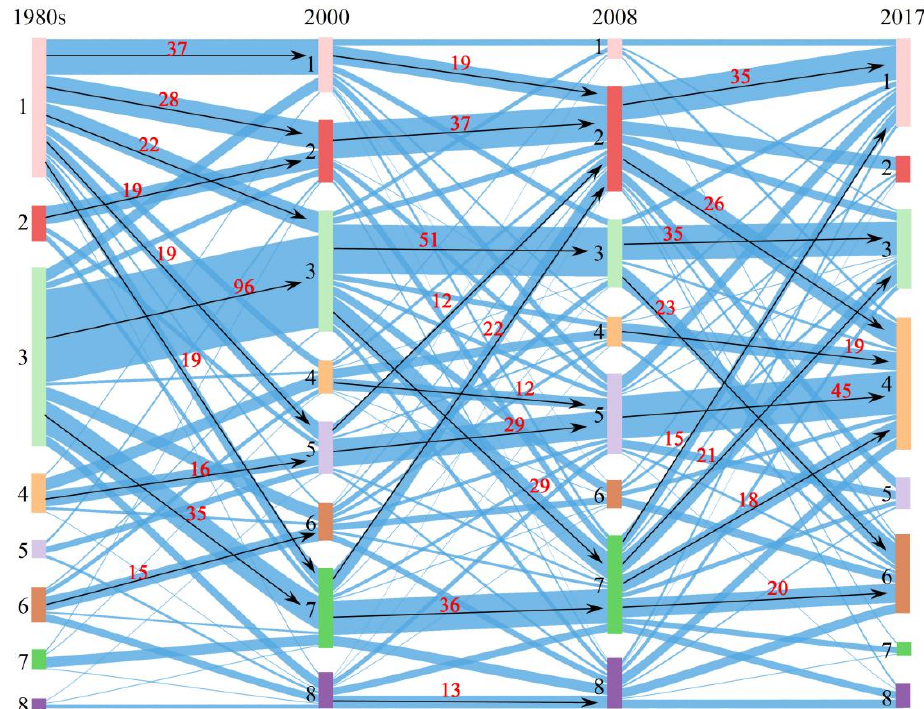
Figure 5. Sankey diagram of the evolution of livelihood structure of 451 households since the 1980s. Notes: Arrows indicate the top 10 tracks in each stage, arrows numbers represent the number of households on the track; Code1 – 8 in the vertical coordinates in order denotes Barren type, SJ income type, TF income type, NF income type, Joint income of SJ & NF, Joint income of TF & NF, Joint income of TF & SJ, Comprehensive type.